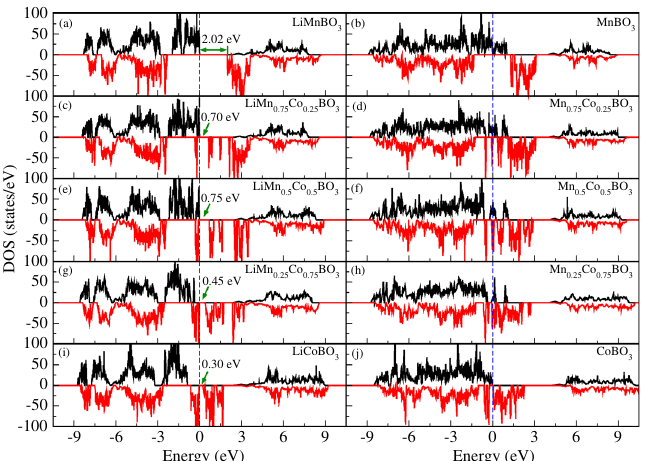
Figure 2. Density of states of fully lithiated ( y = 1 ; left panel) and delitiated ( y = 0 ; right panel) Li y Mn 1 − x Co x BO 3 crystals calculated using GGA. The Fermi level is indicated by a vertical dashed